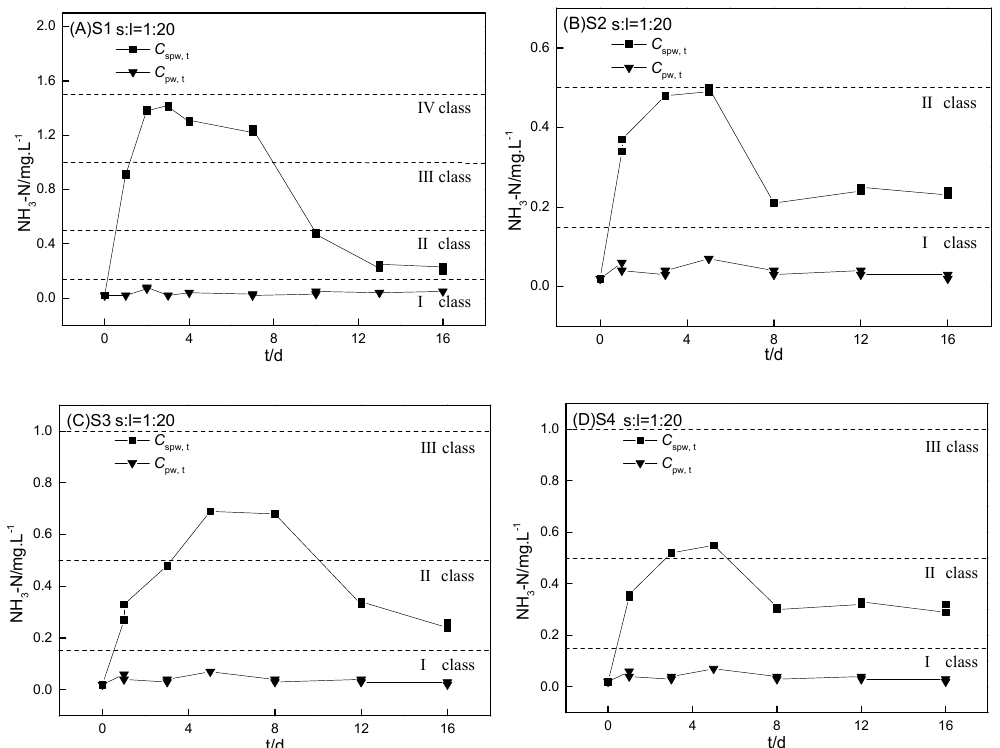
Figure 3. Kinetics of ammonium release from four sediments (S1–S4) incubated in ultrapure water ( C spw, t ). The sediment-to-water ratio was 1:20 for the four sediments. The controls were the kinetics of ammonium incubation in ultrapure water ( C pw, t ) without sediments.